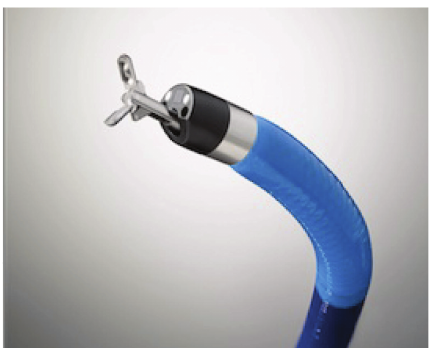
Figure 1: SpyGlass DS: cholangioscopy single-operator platform.